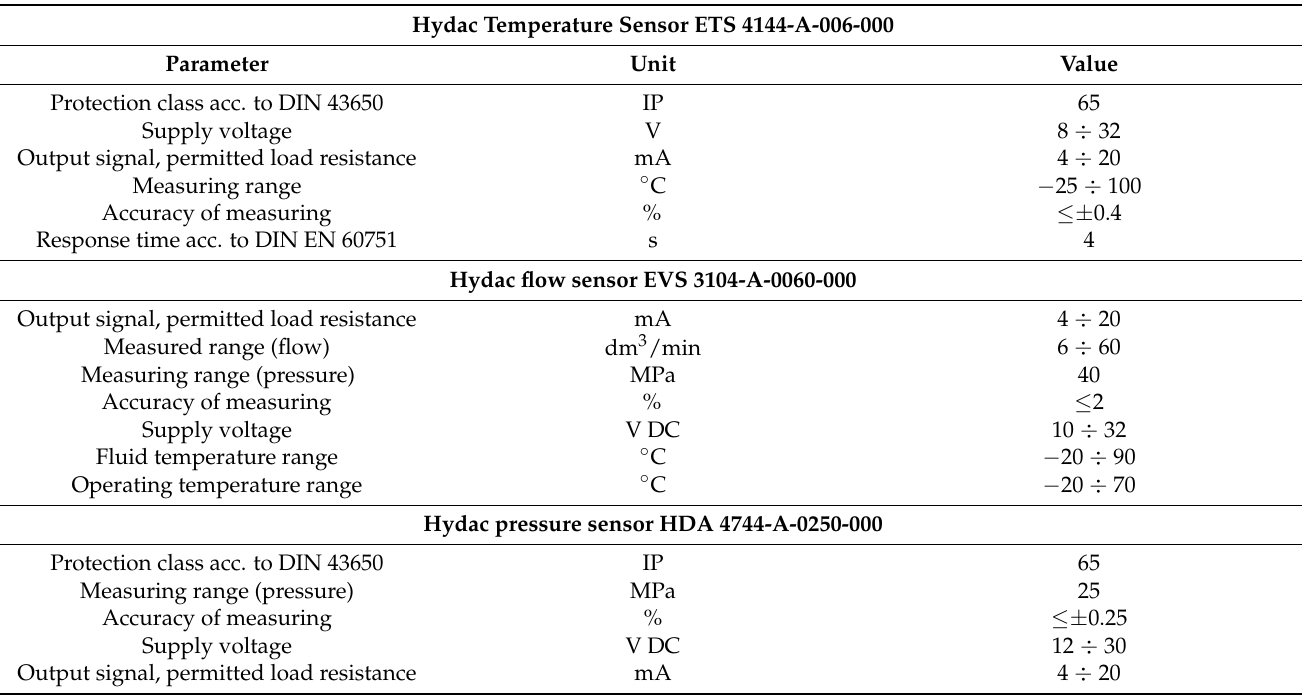
Table 1. Basic data of flow, pressure, and temperature sensors